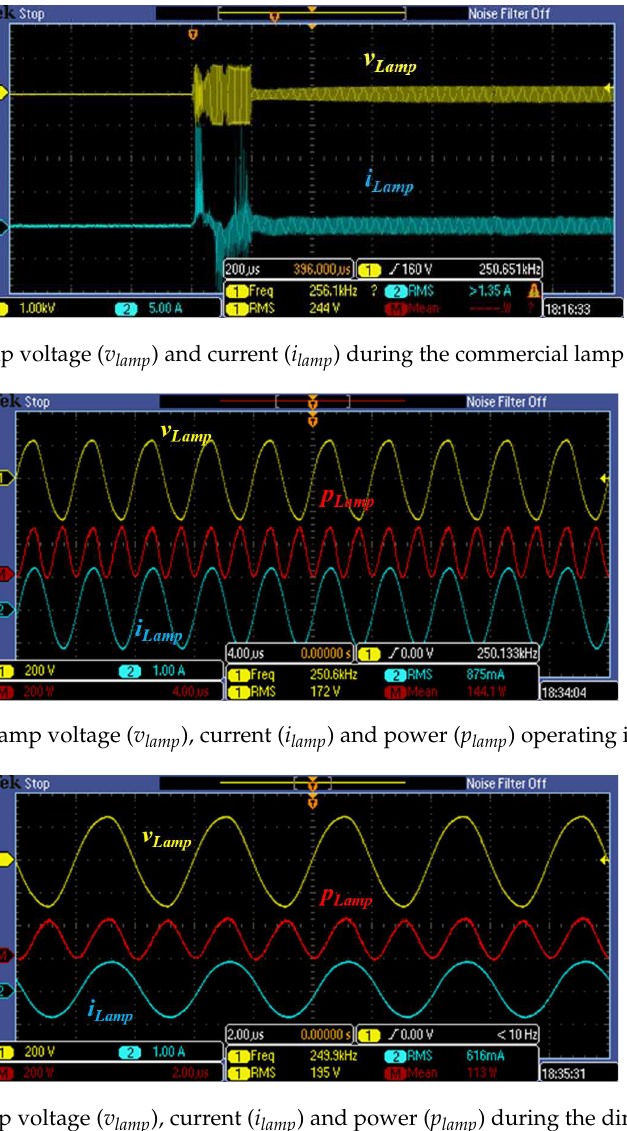
Figure 16. EFL lamp voltage ( v lamp ), current ( i lamp ) and power ( p lamp ) during the dimming operation.